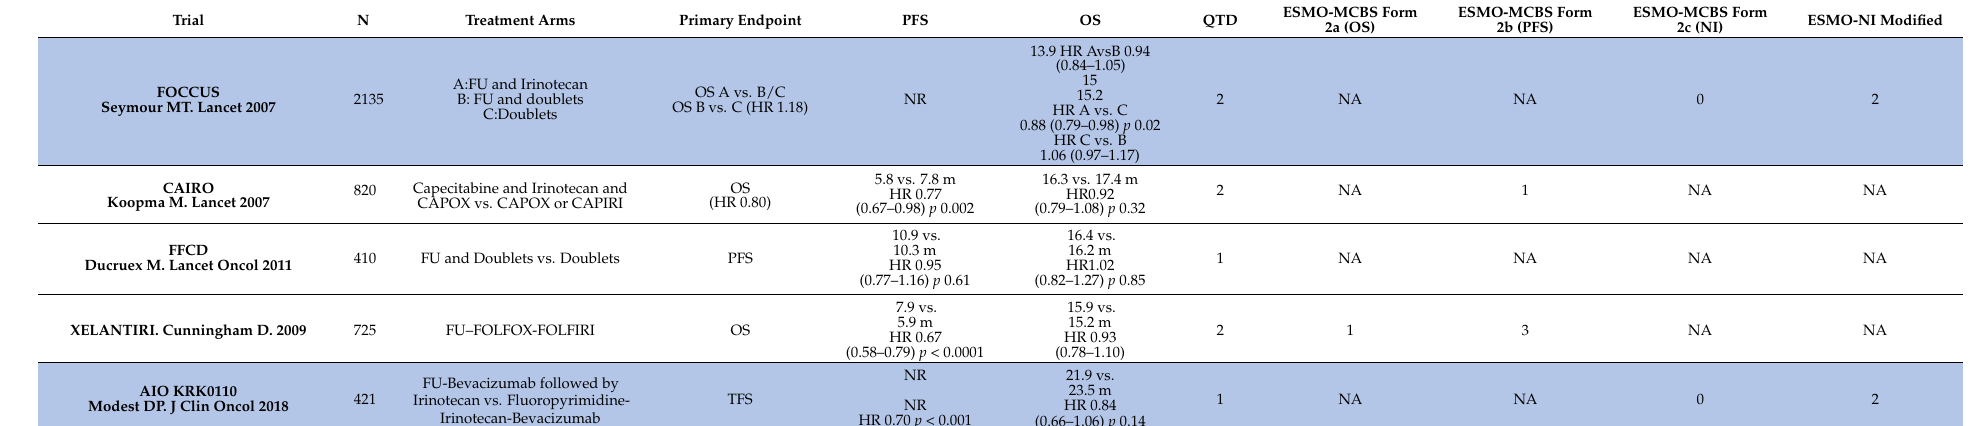
Table 6. Sequential treatment with monotherapy versus (vs.) upfront chemotherapy (CT) doublets treatment.